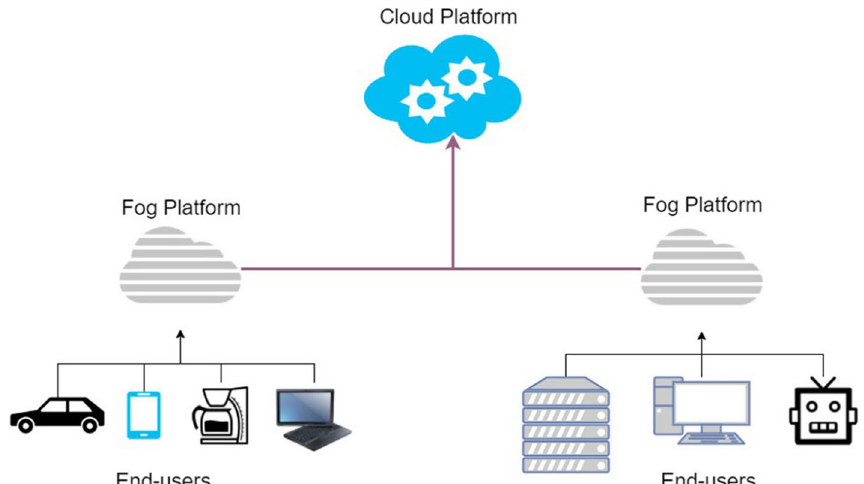
Fig. 1 Cisco’s proposed fog computing